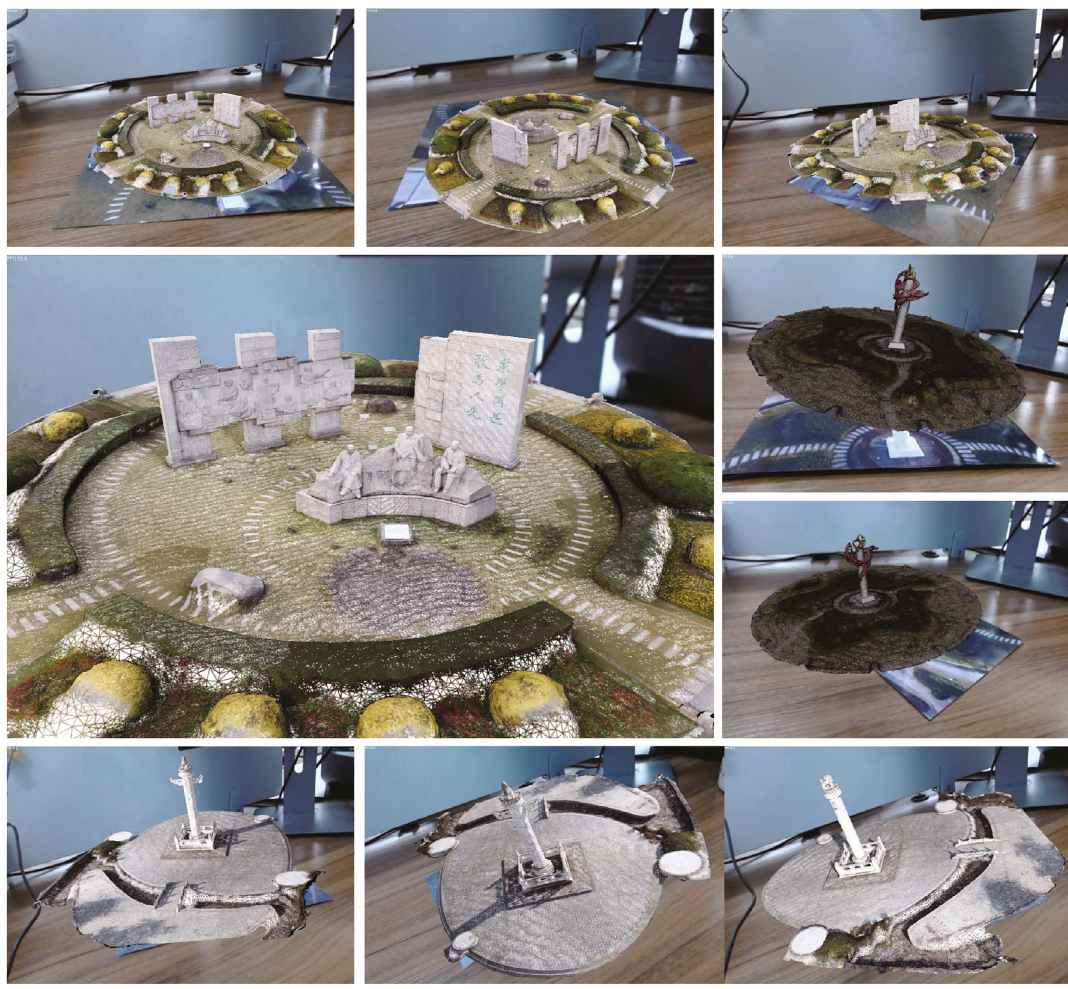
Figure 9: AR fusion e ff